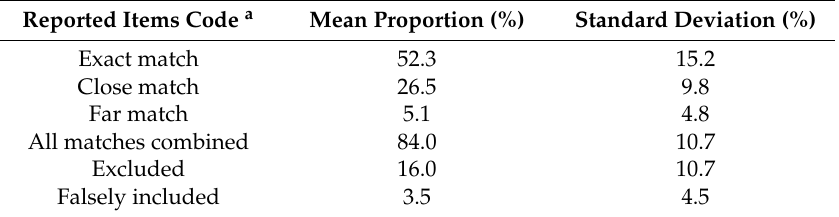
Table 1. Mean proportions of Automated Self-Administered 24-h recall (ASA24) reported types of food/beverage coded as exact matches, close matches, far matches, excluded or falsely included items as compared to actually consumed items by overweight and obese female respondents.